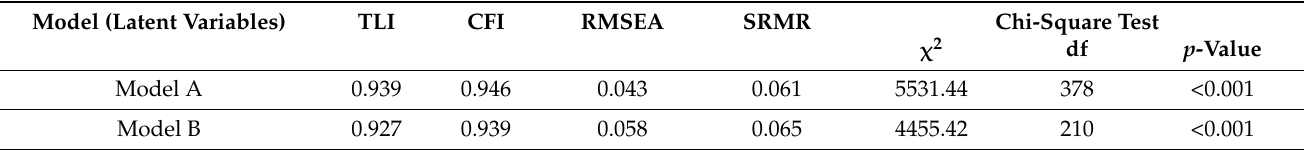
Table 3. Fit statistics for each structural equation model.